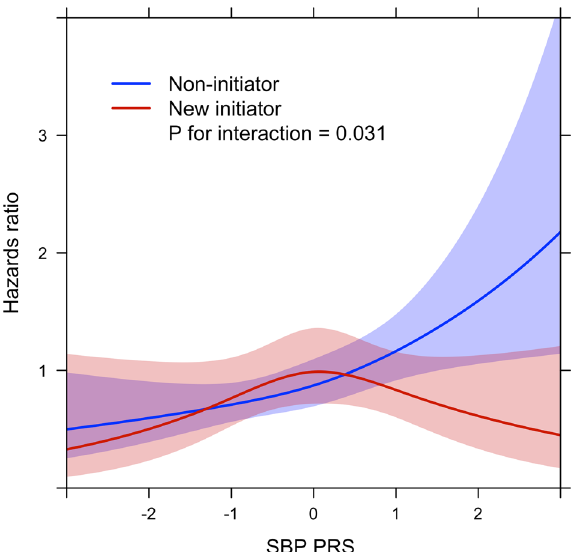
Figure 2. Interaction between systolic blood pressure polygenic risk score (SBP PRS) and new initiation of antihypertensive medication for liver-related outcomes by time-dependent Cox regression analysis using restricted cubic splines. SBP PRS is standardized as per 1 SD. The light red and light blue areas reflect 95% confidence intervals.